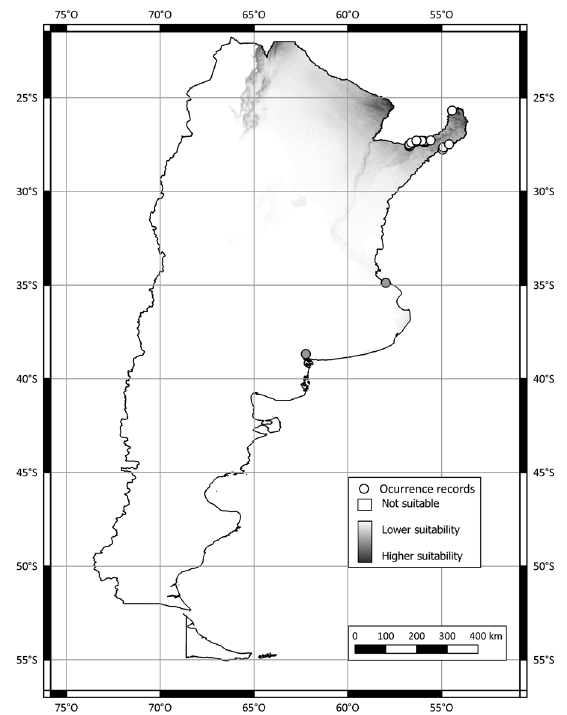
Figure 4. Occurrence records of Melanoides tuberculata in Argentina (white dots) and environmental suitability estimated with MaxEnt species distribution model. Grey dots indicate two records from aquarium shops in La Plata city and from the geothermally warmed channel in La Carrindanga Road (Bahía Blanca